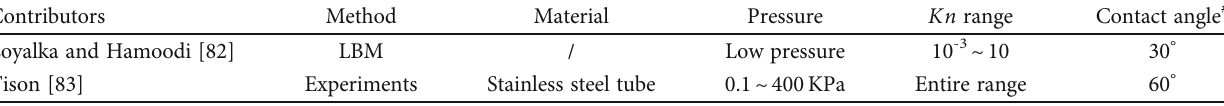
Table 1: The basic parameters to reproduce the bulk-like gas fl ow behavior.